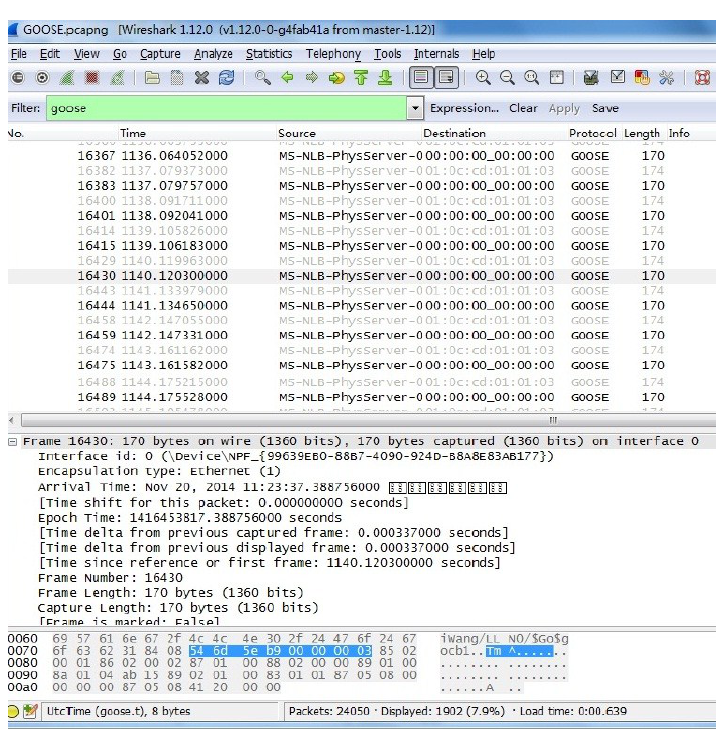
Figure A10. Tests on communication delay of negotiation between HAM_LC and